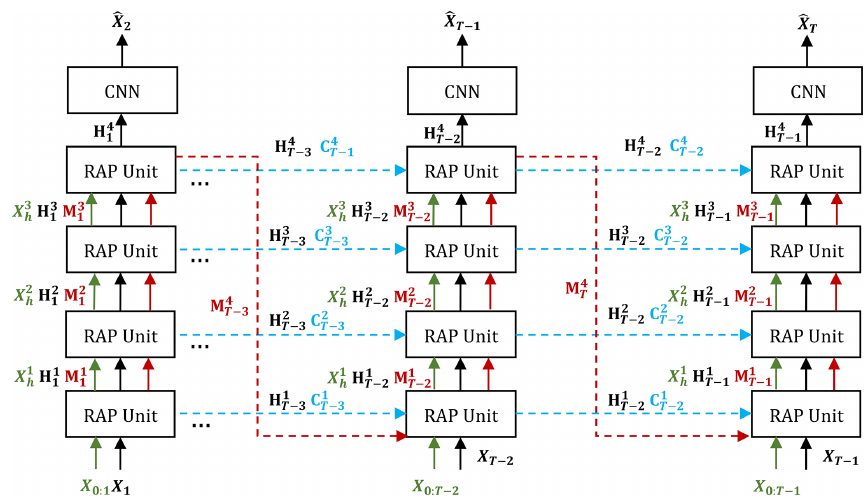
Figure 1. The overall architecture of the Region Attention Predictive Network